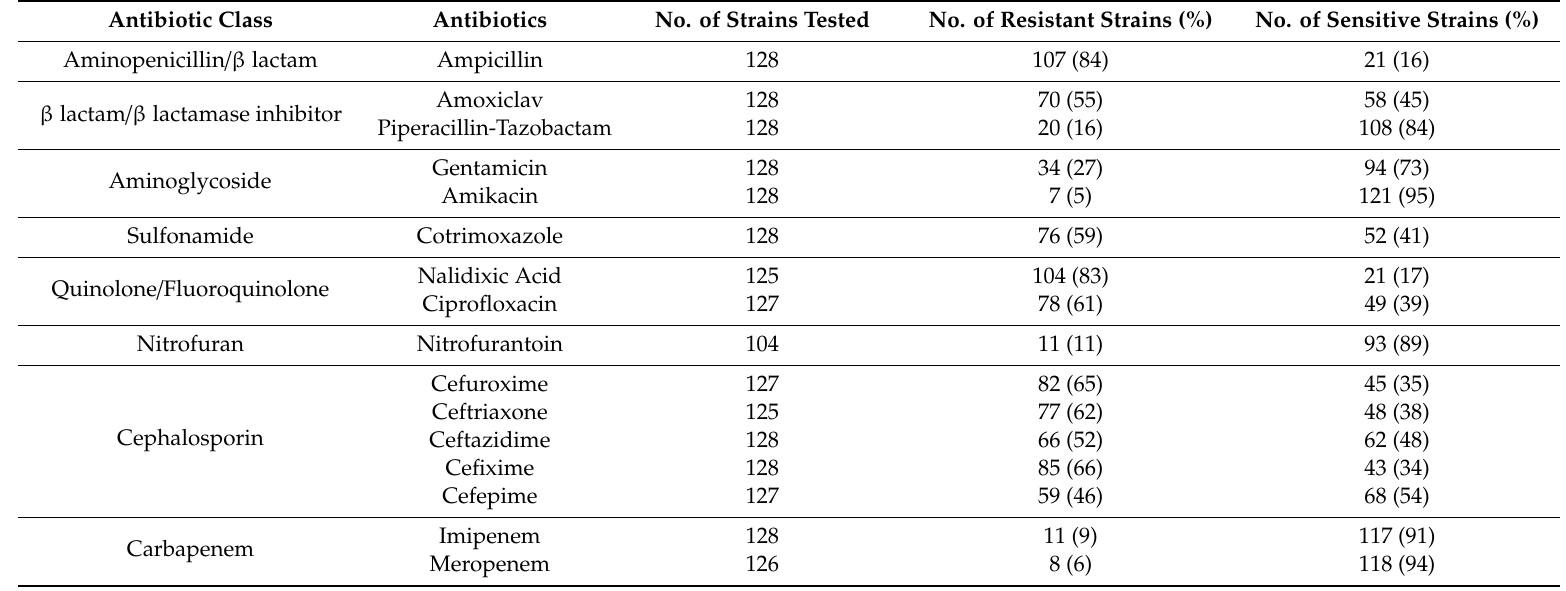
Table 1. Antimicrobial resistance trends of clinical E. coli isolates to 17 antibiotics from March 2018 to July